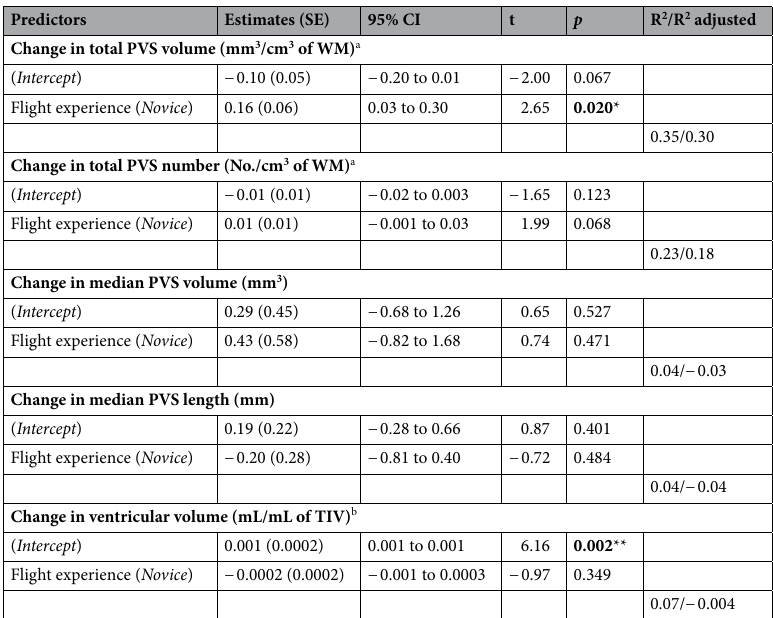
nificant increase from pre- to post-flight for the whole group ( p < 0.001; Table S2), though there was no effect of experience level on ventricular volume changes ( p > 0.05; Table 3). Correlation between past flight experience and baseline PVS characteristics. The correlations between past flight experience and baseline PVS characteristics are summarized in Table S3. Among the expe- rienced astronauts ( n = 6), there were no statistically significant relationships between past flight experience and